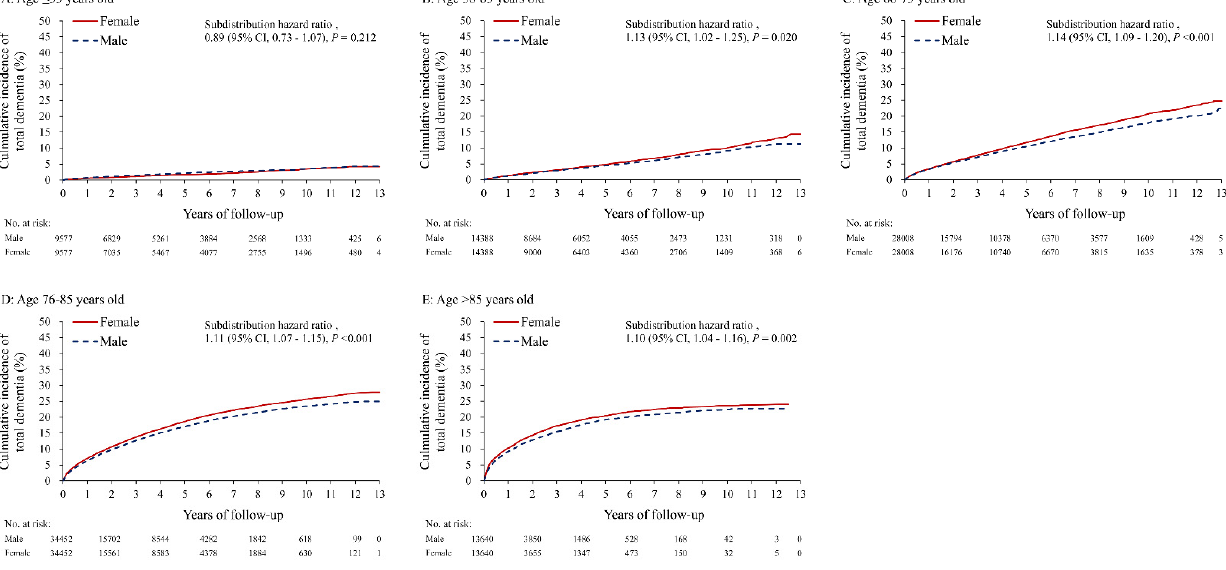
Figure 3. The cumulative incidence (under the Fine and Gray sub distribution model) of any dementia between male and female patients with atrial fibrillation stratified by age in the propensity score matched cohort. (A) age ≤ 55 years old, (B) age 56-65 years old, (C) age 66-75 years old, (D) age 76-85 years old, (E) age > 85 years old.